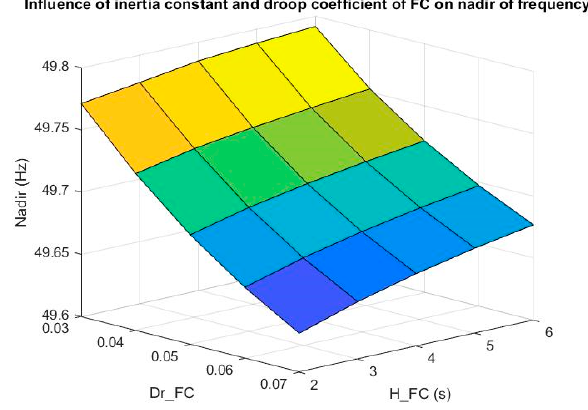
Figure 8. Influence of H and